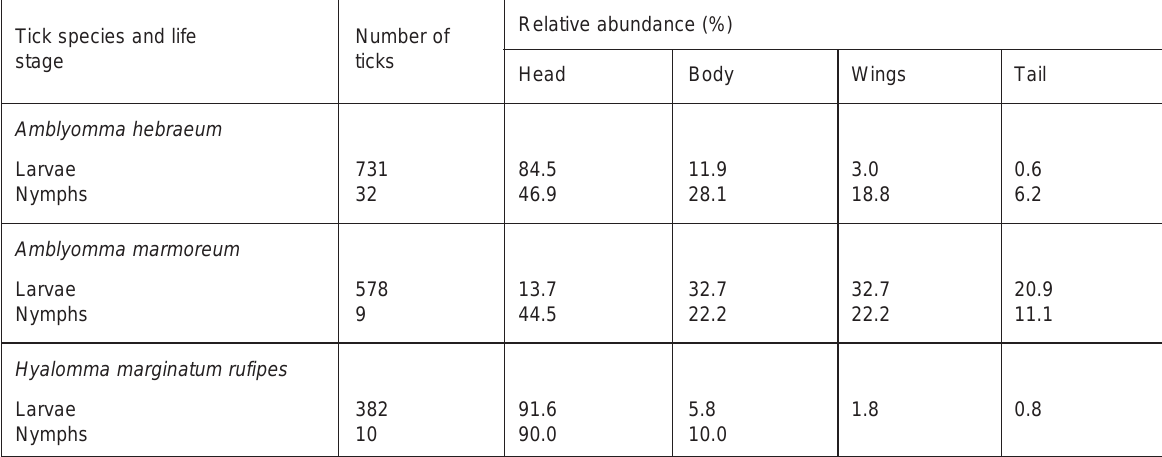
TABLE 2 The attachment distribution of ticks on 18 crested francolins on the farm “Sandspruit”, Limpopo Province Tick species and life